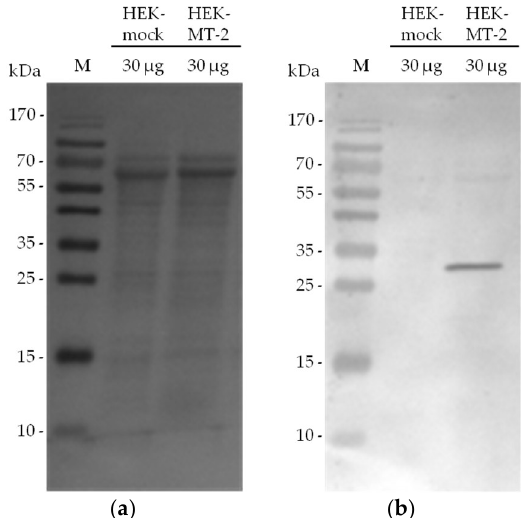
panel b). This band represents the catalytic domain of the enzyme. The corresponding band was lacking in the culture supernatant of HEK-mock cells expressing an empty vector.